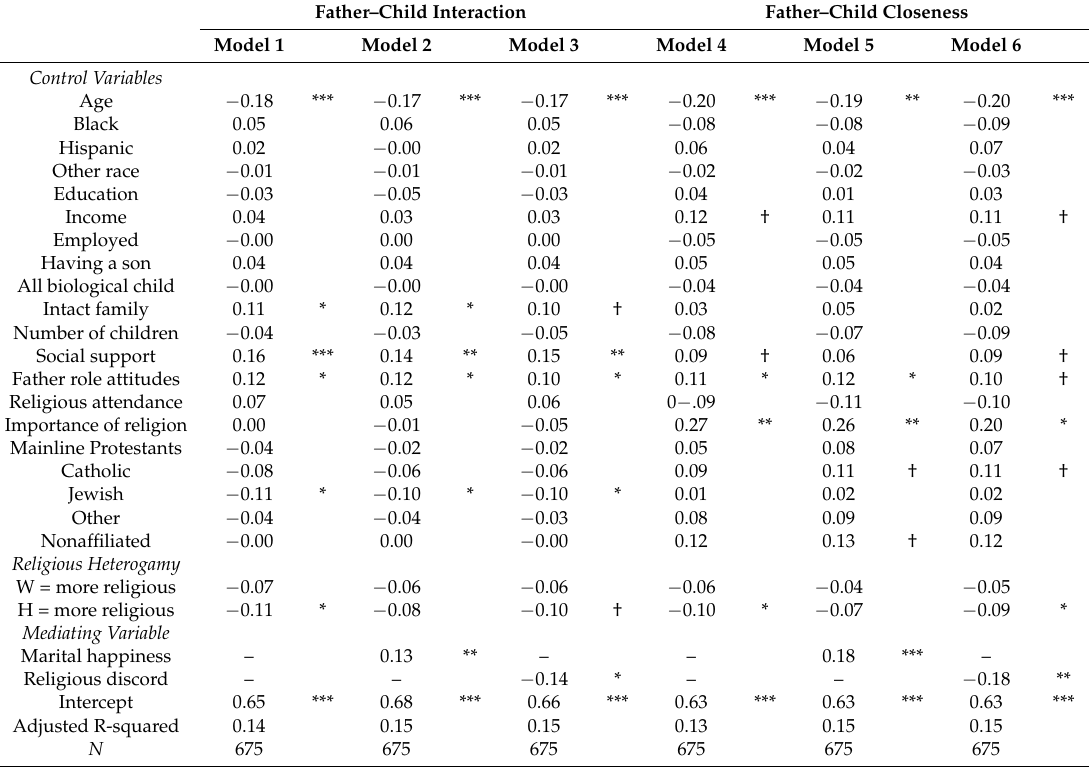
Table A2. Ordinary least squares regression of paternal engagement on religious heterogamy.